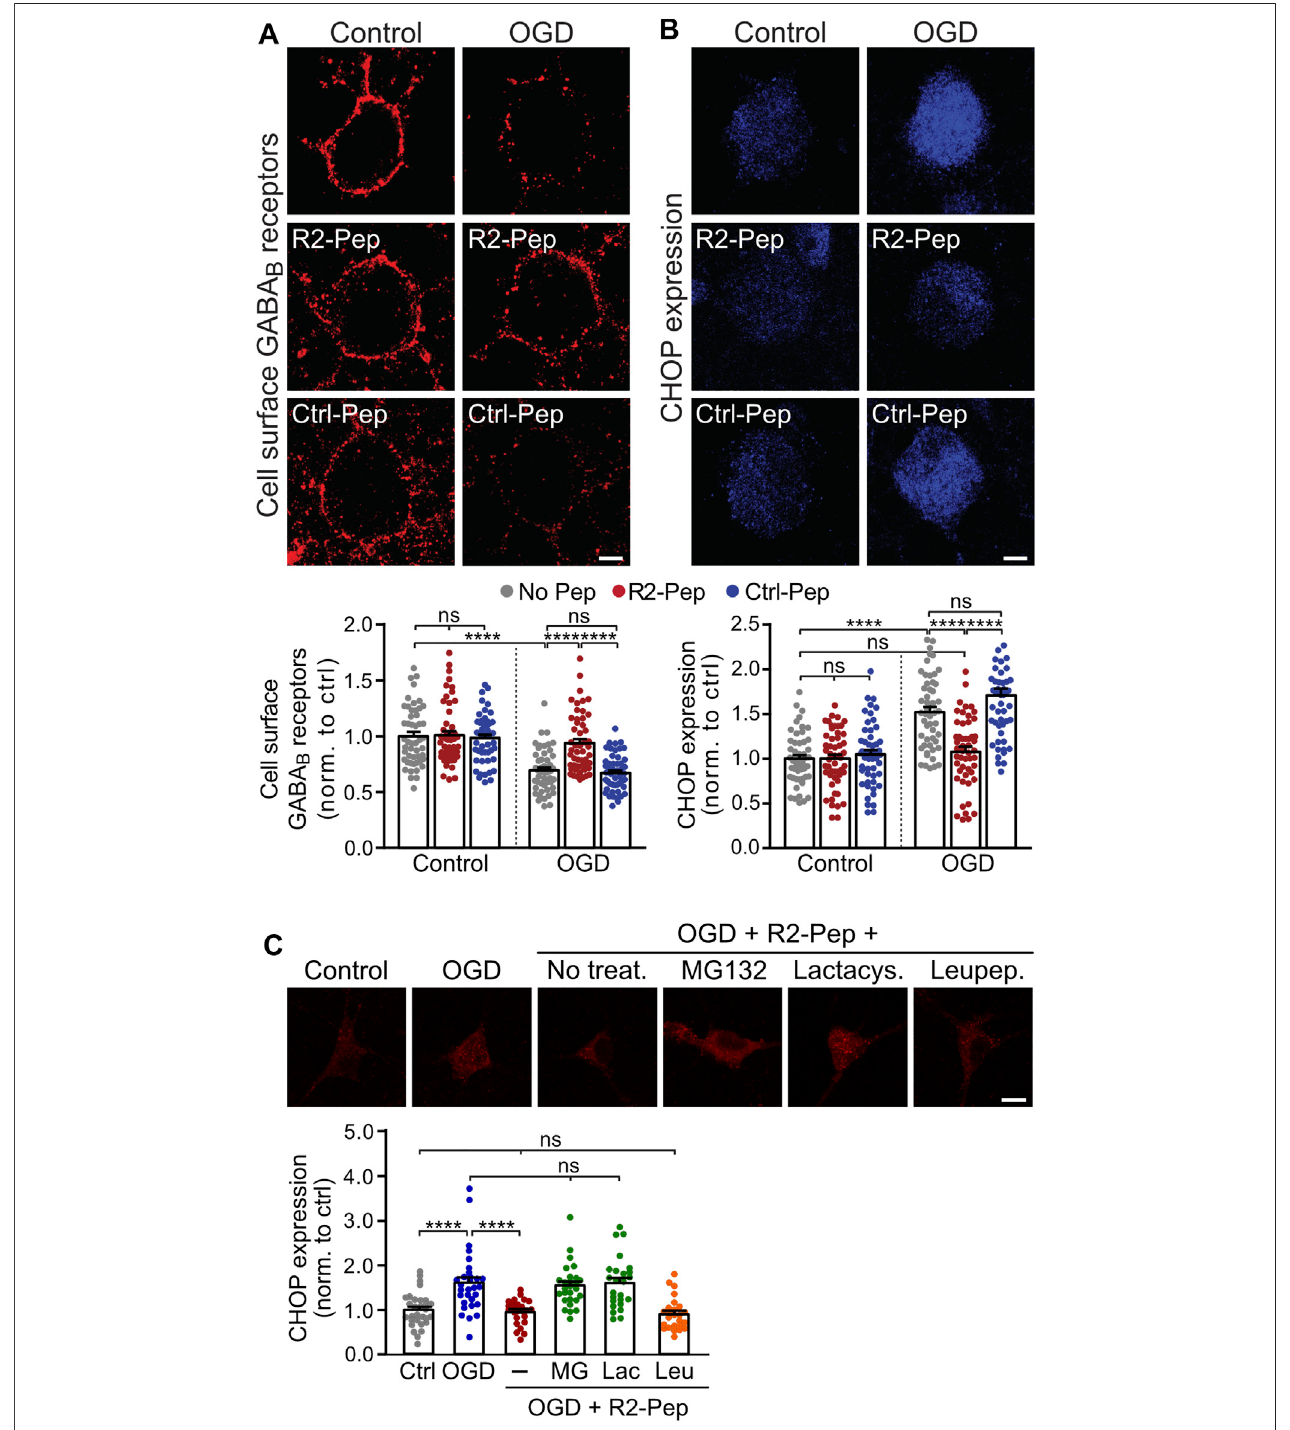
FIGURE 3 | CHOP-mediated down-regulation of cell surface GABA B receptors is rescued by R2-Pep. (A) and (B) , Cultures were stressed for 1 h with OGD and immediately thereafter treated with R2-Pep, the inactive Ctrl-Pep or remained untreated. The neurons were immunostained for cell surface GABA B2 (A) and CHOP (B) 16 h after OGD stress. Top: representative images (scale bar: 5 μ m). Bottom: quanti fi cation of fl uorescence intensities. The fl uorescence intensity of the untreated neuronsservedascontrols.Thedatarepresentthemean±S.E.M.of49 – 53neuronsforeachexperimentalconditionderivedfromthreeindependentexperiments. ns, p > 0.05; ****; p < 0.0001; two-way ANOVA with Tukey ’ s multiple comparisons test. (C) R2-Pep induces proteasomal degradation of CHOP upregulated by OGD. Cultures were stressed for 1 h with OGD and immediately thereafter remained untreated or were treated with R2-Pep in the presence of proteasome inhibitors (50 μ M